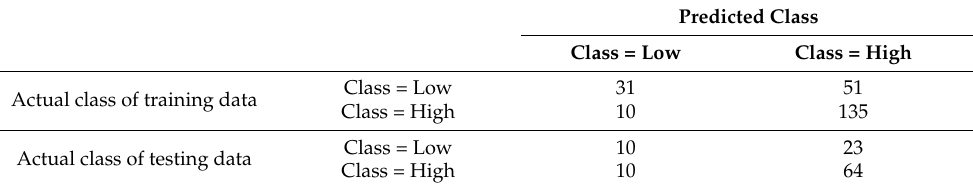
Table 5. Confusion matrix.